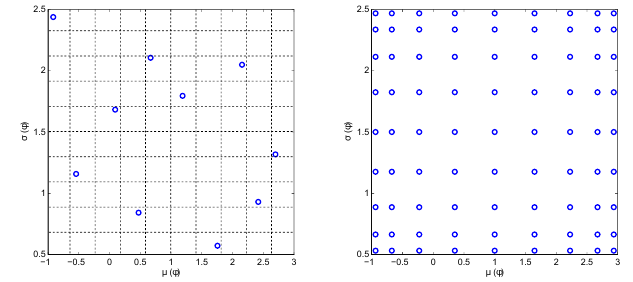
Figure 6. Two-parameters Latin hypercube sampling (LHS) with 10 points (left) and tensor product grid using 9 × 9 Clenshaw–Curtis points